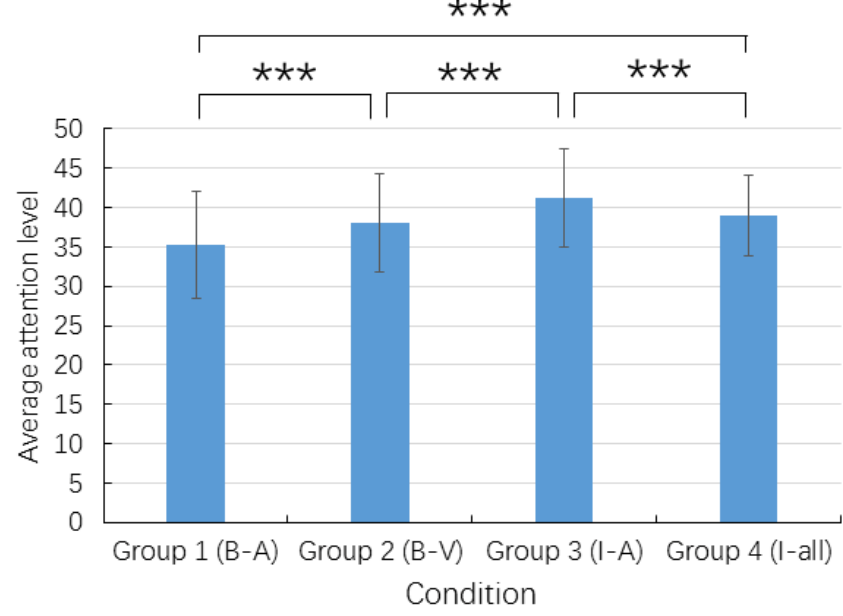
Figure 4. Average attention level by condition. *** p < 0.001.